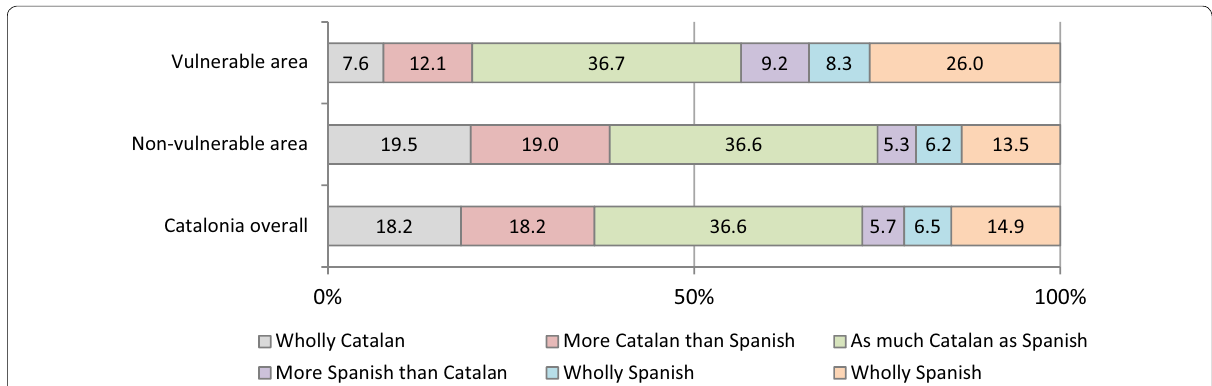
Fig. 3 Feeling of belonging in the young population of Catalonia according to the level of urban segregation (2017) (Source: Own elaboration from the data provided by the Enquesta de Joventut de Catalunya,